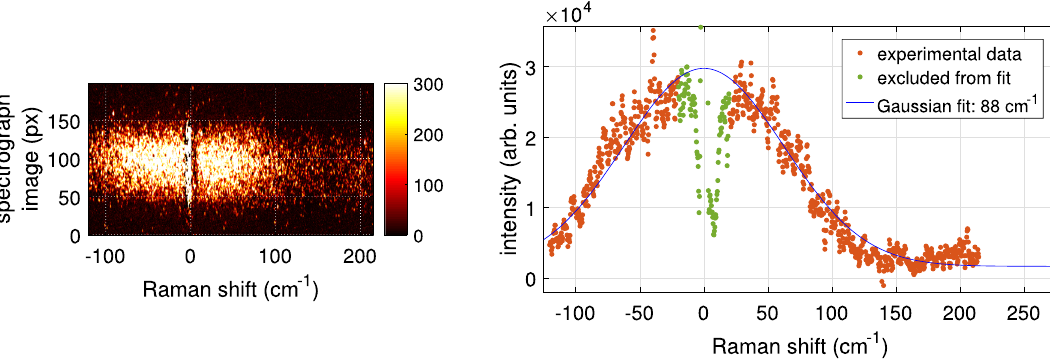
Figure 6. Thomson signal obtained using 3000 exposures taken 800 ns after the start of the applied pulse in the case of 680 k (cid:31) resistor. The Gaussian fit was used to deduce the electron density and temperature, using the calibration from Fig. 5, resulting in ( 1.4